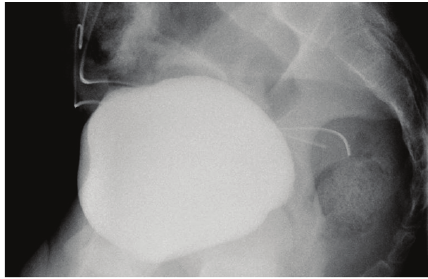
Figure 2: Retrograde cystography demonstrating normal integrity of the urinary bladder (no contrast